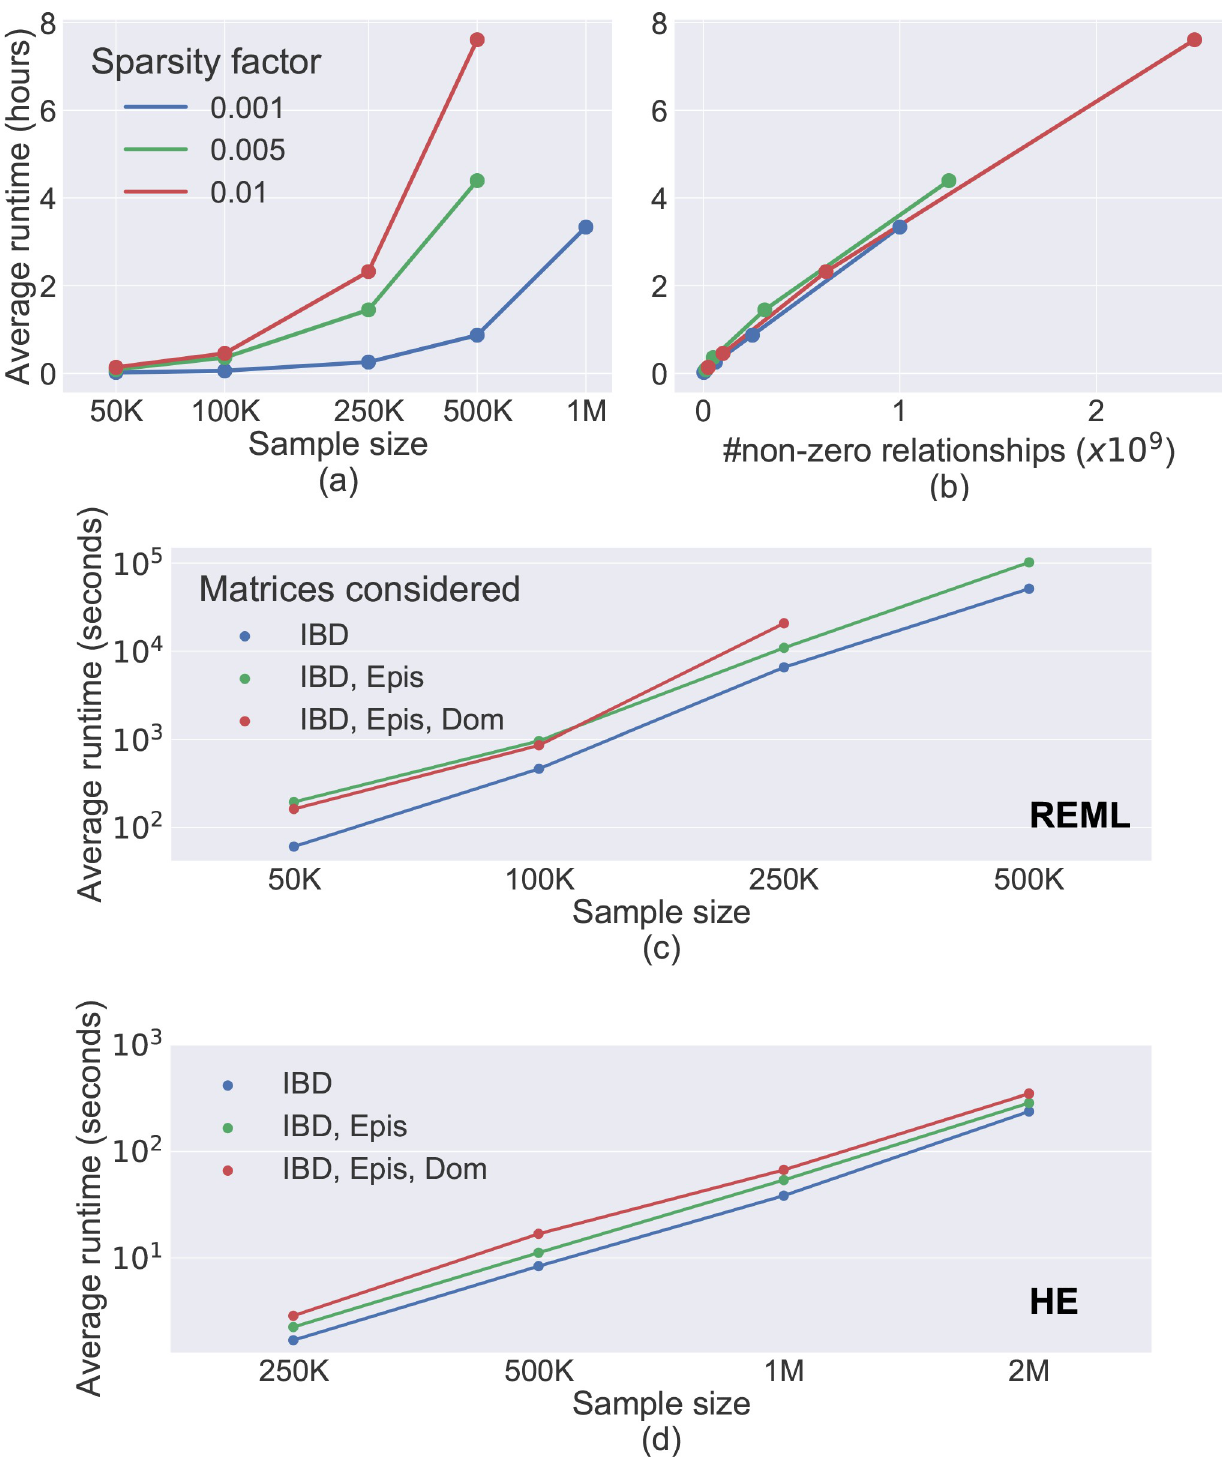
Fig 3. Analysis of Sci-LMM computation time. (a) Computation time required to compute an IBD matrix from pedigree data under different sparsity factors as a function of sample size. (b) Computation time required to compute an IBD matrix from pedigree data as a function of the number of nonzero relationships, demonstrating a linear relationship. The maximal number of evaluated non-zero relationships increases with the sparsity cutoff, because we only generated matrices with up to a million individuals. (c) Variance component estimation time (using REML), as a function of sample size, when using different combinations of covariance matrices. Epis–Epistasis; Dom—dominance (d) same as (c), but for HE regression instead of REML estimation. Here